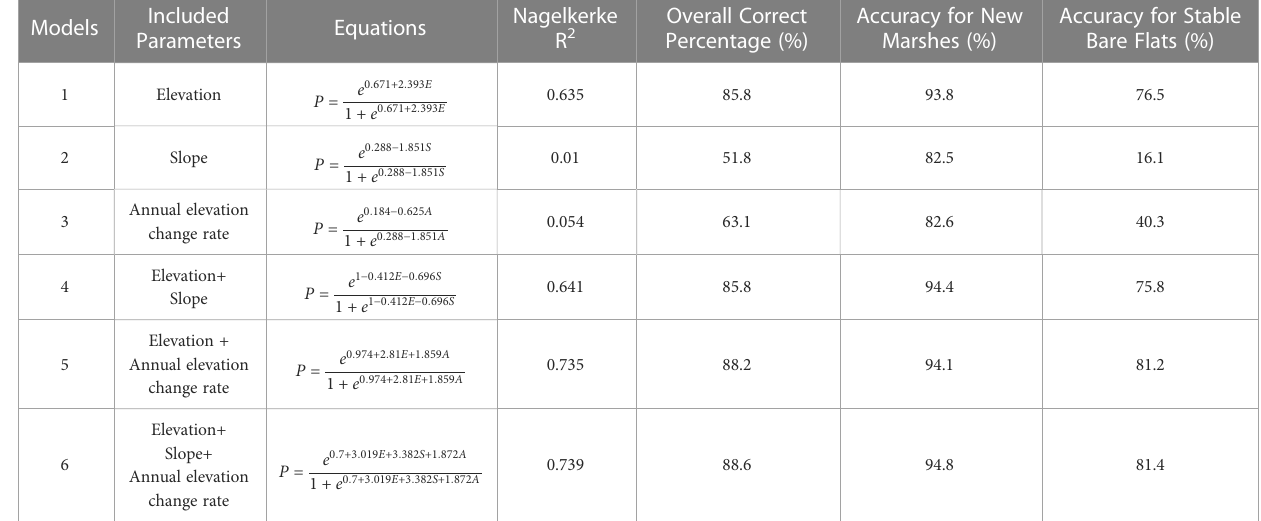
TABLE 2 Logistic regression models as a function of elevation, the annual change rate of elevation, and slope, with evaluating coef fi cients. Included Models